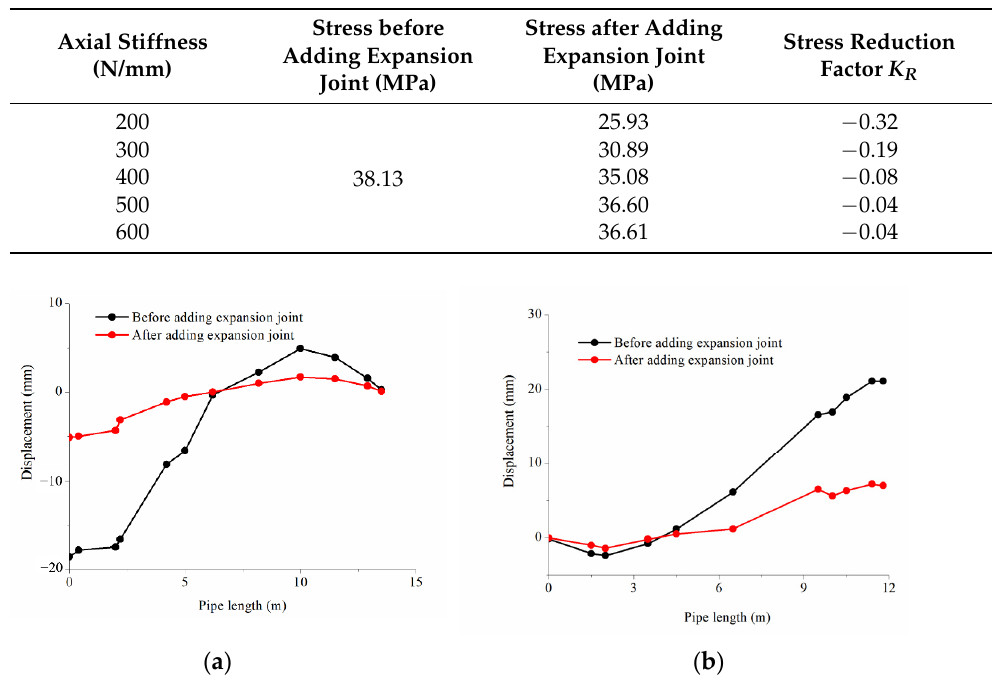
Figure 19. Displacement comparison before and after adding the expansion joint ( a ) RC1 compressor inlet pipe; ( b ) RC1 compressor outlet pipe. Table 9. The stresses of RC1-B4 after adding different kinds of expansion joints.